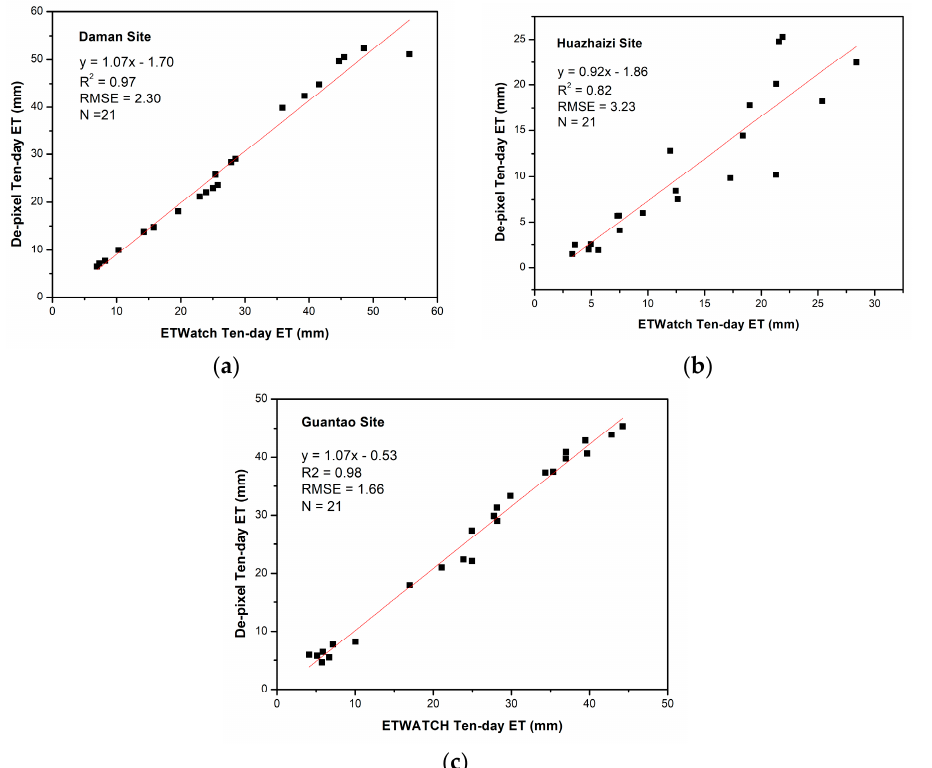
Figure 5. Comparison of ten-day Eta values obtained from the original ETWATCH product and the downscaled 30-m ET values obtained by applying the “de-pixelation” method to three sites: ( a ) Daman; ( b ) Huazhaizi; and ( c ) Guantao ( n = 21).